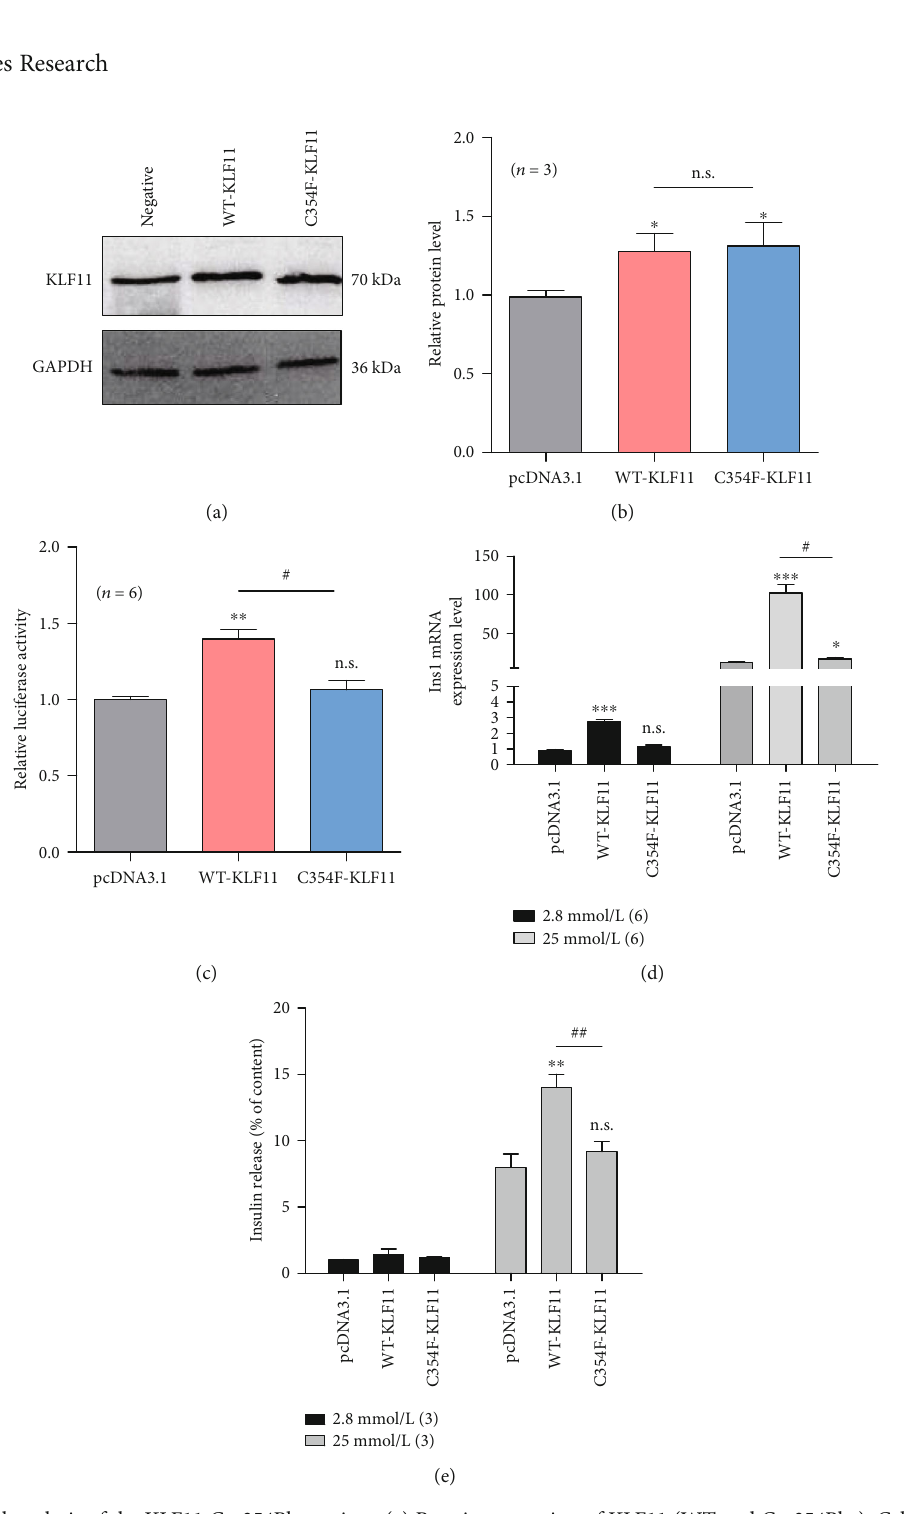
Figure 3: Functional analysis of the KLF11 Cys354Phe variant. (a) Protein expression of KLF11 (WT and Cys354Phe). Cell lysates of KLF11- expressing cells were used. Protein production was tested via western blotting. (b) Histogram of the KLF11 protein expression level analysis. (c) Luciferase assays of HEK 293 cells transfected with each KLF11 expression vector (WT and Cys354Phe). ∗∗ denotes p < 0 : 01 ( p = 0 : 0031 ) for the KLF11 WT plasmid compared to the empty plasmid; n.s. denotes p > 0 : 05 ( p = 0 : 3899 ) for KFL11/C354F compared to the empty plasmid; # denotes p < 0 : 05 ( p = 0 : 0176 ) for KFL11/C354F compared to KLF11 WT. (d – f) INS1 cells were transfected with the KLF11-WT or KLF11- Cys354Phe plasmids for 24 (d) or 48h (e). (d) qRT-PCR was conducted to determine the Ins1 mRNA levels after stimulation with 2.8mmol/L glucose (low) or 20mmol/L glucose (high) for 24h. (e) Insulin secretion levels in INS1 cells were analyzed via glucose-stimulated insulin secretion assay using ELISA after stimulation with 2.8mmol/L glucose (low) or 20mmol/L glucose (high) for 2h. Note: n denotes the number of experiments. ∗∗ denotes p < 0 : 01 ( p = 0 : 0018 ) for KLF11 WT compared to the empty plasmid; n.s. denotes p > 0 : 05 ( p = 0 : 1836 ) for KFL11/C354F compared to the empty plasmid; ## denotes p < 0 : 01 ( p = 0 : 0027 ) for KFL11/C354F compared to KLF11